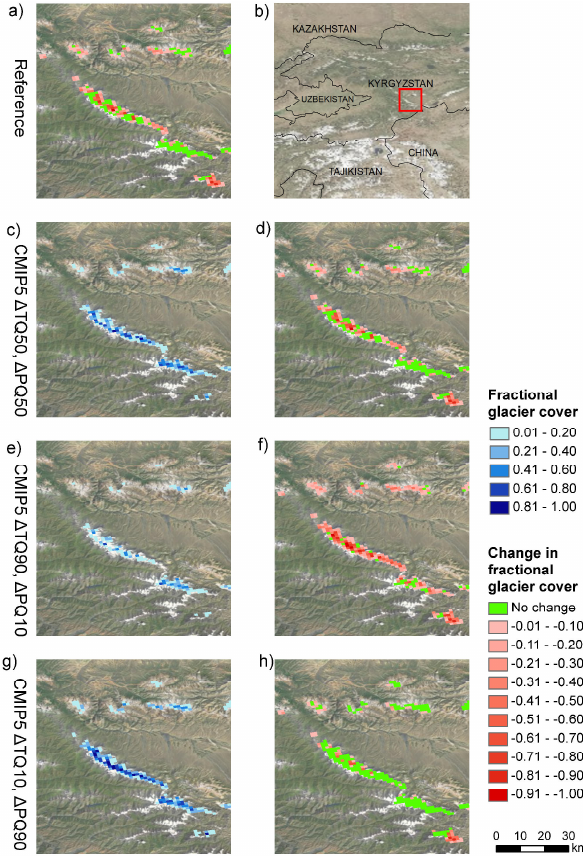
Fig. 14. Projected fractional glacier cover in 2050 for the Fedchenko area in the Central Pamir. The square in the top right panel (b) rep- resents the area enlarged in the other panels. Panel (a) shows the initial fractional glacier cover per 1km grid cell. The three lower left panels show the simulated fractional glacier cover per 1km grid cell in 2050 for the CMIP5 runs. Panel (c) shows the fractional glacier cover for the run with the 50th percentile (Q50) values of temperature and precipitation change. Panel (e) shows the projec- tion with the strongest decrease in glacier cover, when the model is forced with the 90th percentile (Q90) for temperature change and 10th percentile (Q10) for precipitation change. Panel (g) shows the projection with the least decrease in glacier cover, when the model is forced with the 10th percentile (Q10) for temperature and 90th percentile (Q90) for precipitation change. The three lower right pan- els (d, f, h) show the change in fractional glacier cover per grid cell for the 2050 projections in the three lower left panels (c, e, g) with respect to the initial glacier cover (a) .